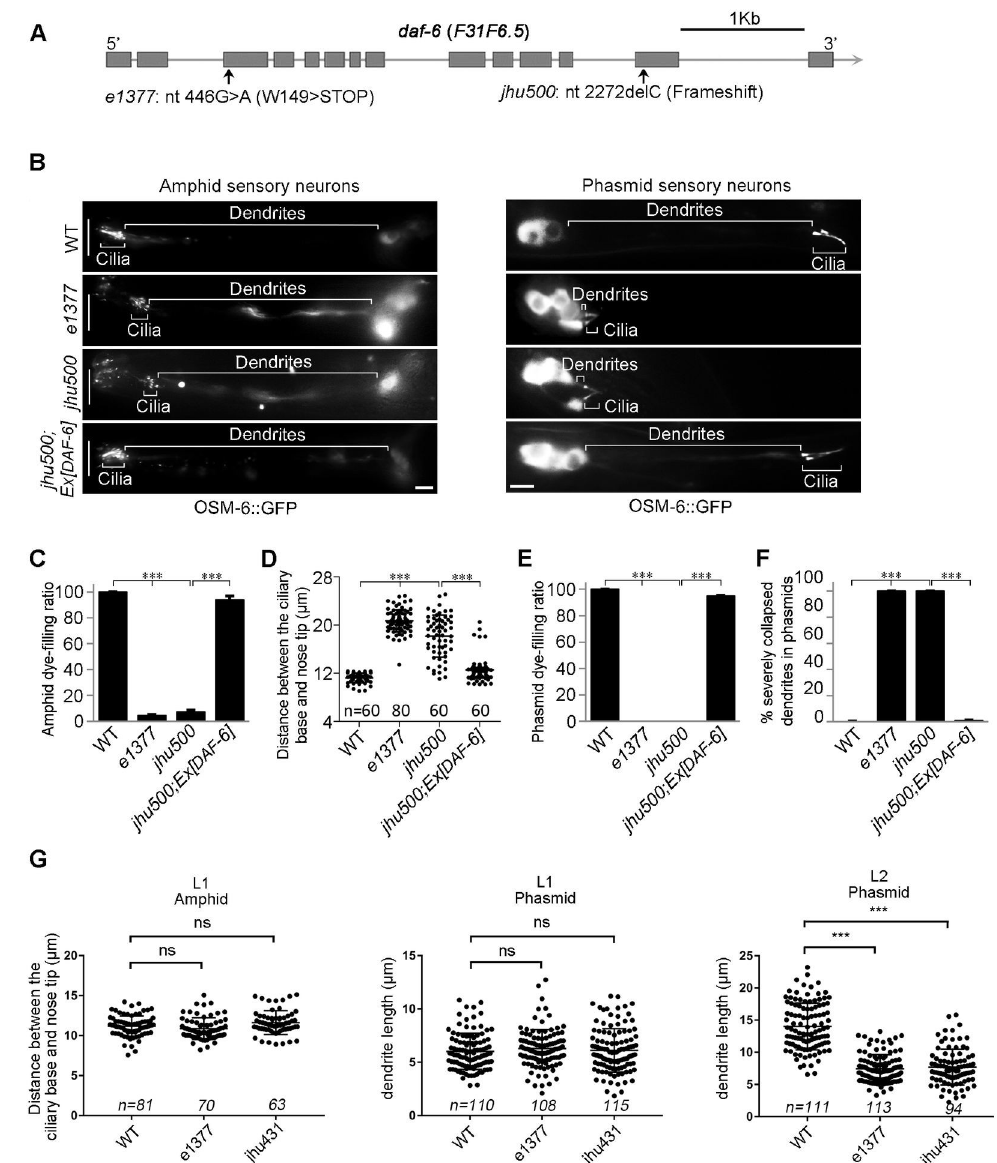
Fig 2. The daf-6 mutant mimics the phenotype of the dyf-4 mutant. (A) Schematic diagram of daf-6 alleles. daf-6(e1377) was previously reported [11]. daf-6(jhu500) has a 1-bp deletion (c.2272delC) at its C-terminus, leading to a frameshift. (B) Fluorescence micrographs of sensory neurons in the amphids and phasmids of adult WT, daf-6(e1377) , daf-6(jhu500) and jhu500 ; Ex [DAF-6] worms expressing OSM-6::GFP. The white vertical line at left represents the nose tip position. Scale bars: 5 μ m. (C) Statistics of the dye-filling percentages in the amphids of the indicated worm lines. (D) Statistics of the distance between basal bodies and the nose tip at the head in the indicated worm lines. (E) Statistics of the dye-filling percentages in the phasmids of the indicated worm lines. (F) Statistics of the phasmid dendrite defect ratio in the indicated worm lines. Dendrites with cilia located near the cell bodies are defined as severely collapsed dendrites. Data are presented as the mean ± SEM from three independent experiments (n � 80 per experiment). (G) Analysis of the defects of dendrites at L1 and L2 stages in the indicated worm lines. ��� P < 0.001 (Fisher’s Exact test for Fig 2C, 2E and 2F, Mann-Whitney test for Fig 2D and 2G). in the sheath lumen, DYF-6::GFP accumulated strongly in both cell bodies and sensory com- partment region of glial cells in dyf-4 mutants (Figs 4B and S2D), indicating that DYF-4 is required for the proper localization of DAF-6.